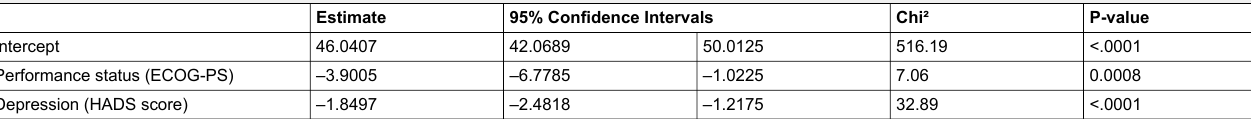
Table 6: Multiple regression model at T2 with fatigue as outcome